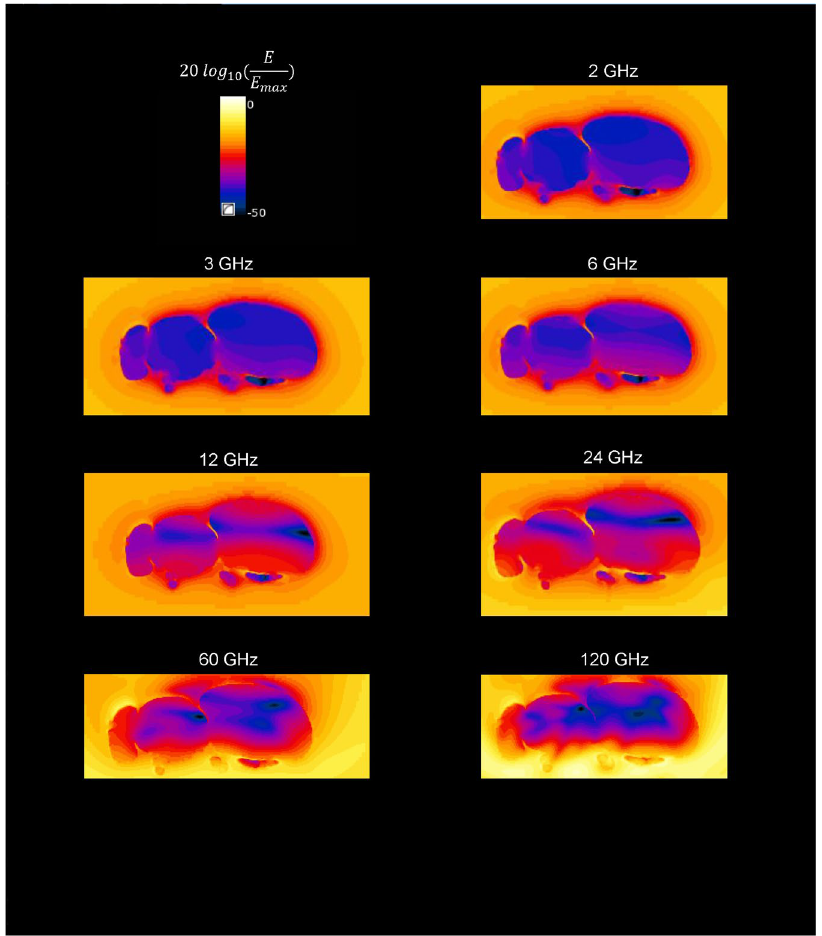
Figure 4. Normalized Electric field strength (dB) in a mid-transverse cross section of the Western Honey Bee as a function of frequency for a single plane wave incident from below with polarization orthogonal to the shown plane (No. 5 in Fig. 1). Normalization was executed for each simulation separately, i.e. E max can be different in each subfigure.